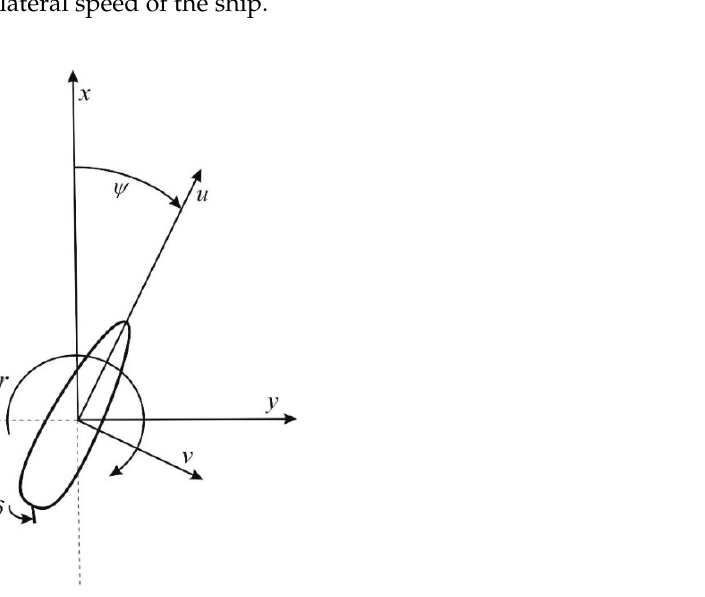
Figure 1. Quantities describing ship movement in the horizontal plane.